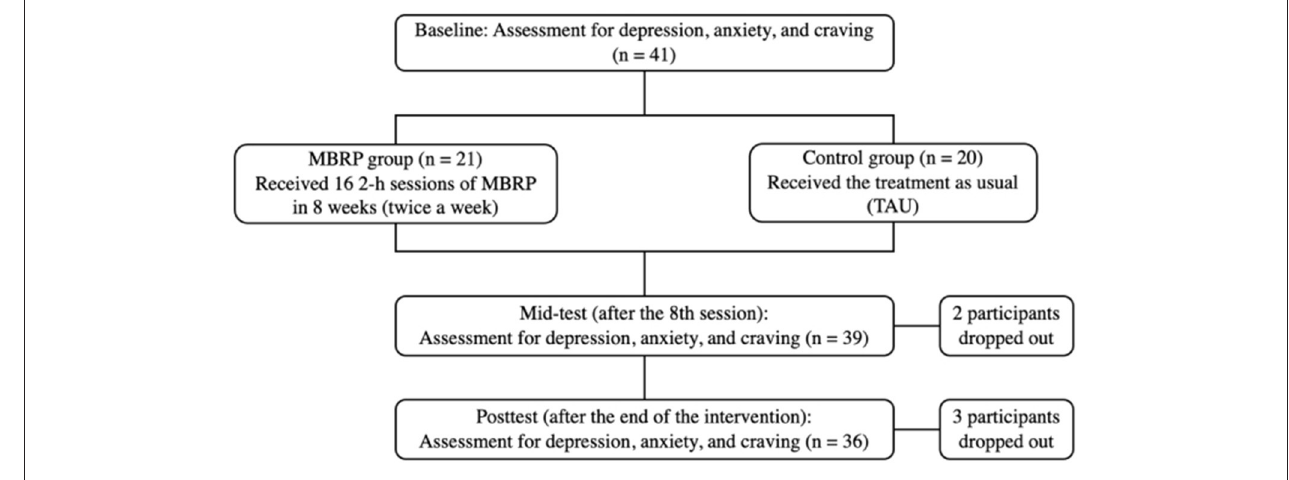
FIGURE 1 | The flow chart of the current study.